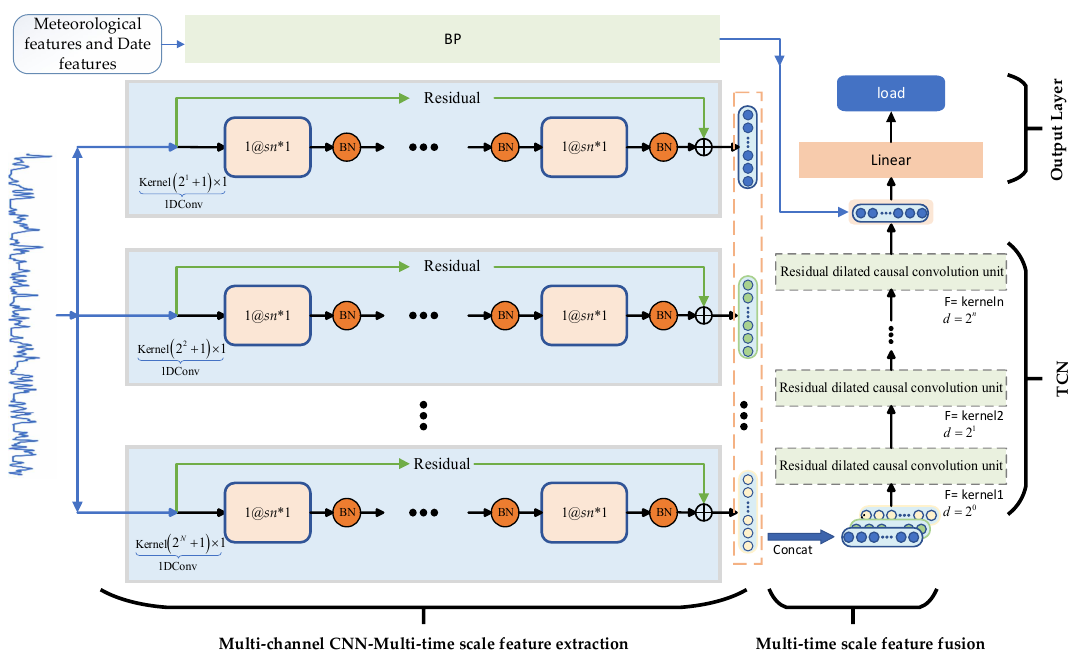
Figure 1. Multi-channel convolutional neural network and temporal convolutional network (Where, @ is preceded by the number of channels and followed by the output of the convolution layer).